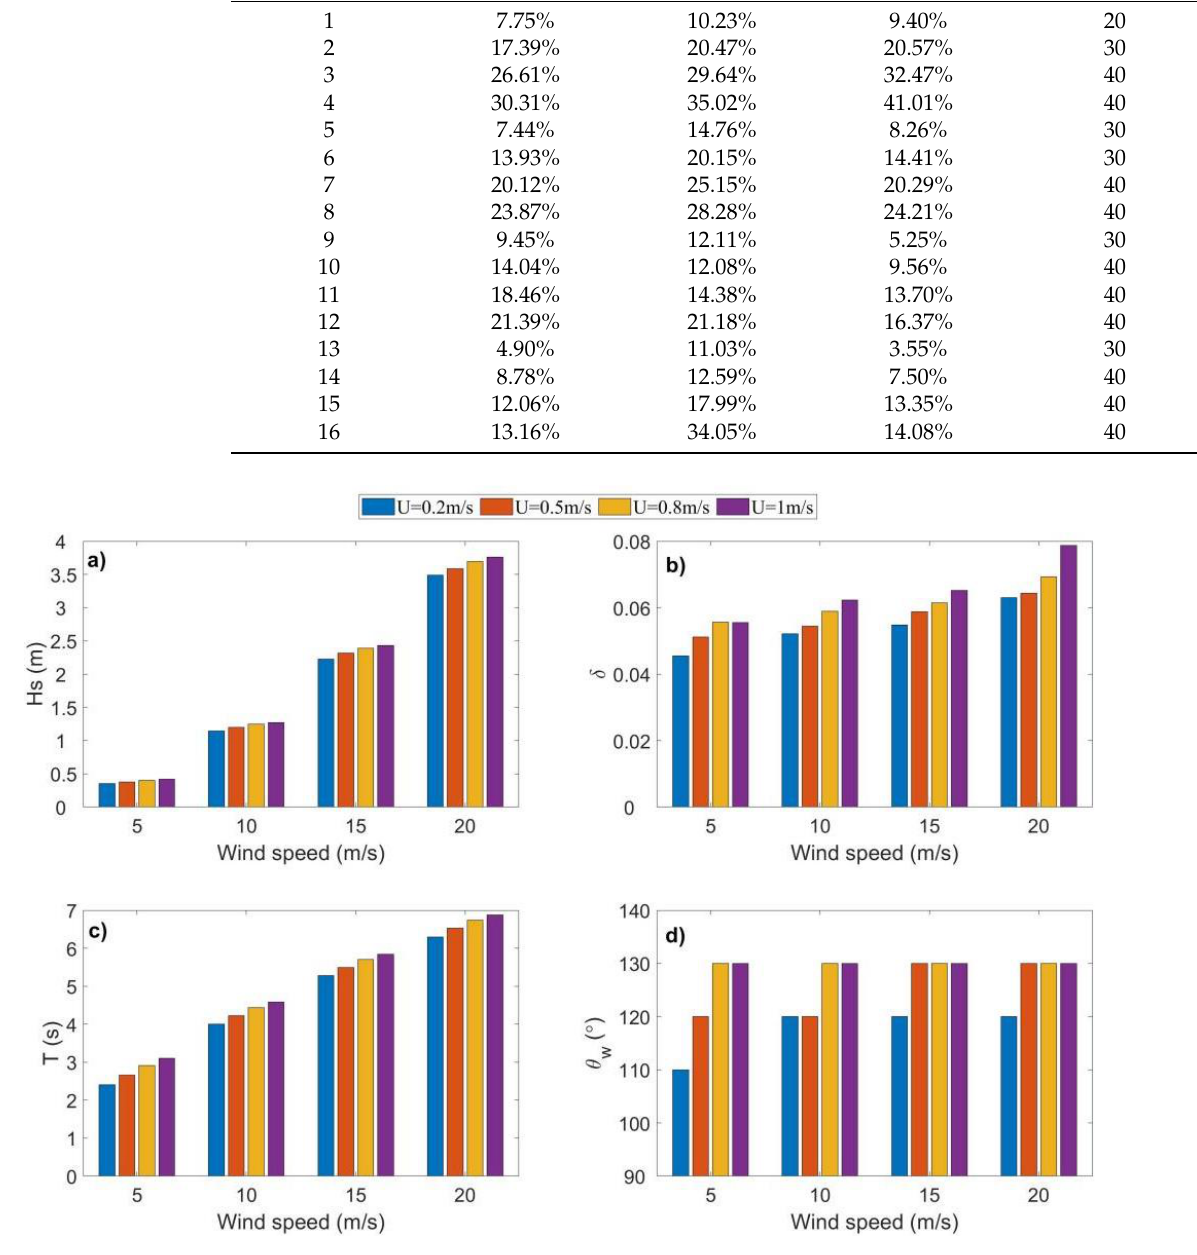
Figure 7. Wave parameters ( a ) H S , ( b ) δ , ( c ) T , and ( d ) θ w for the 16 cases in Table 1. The horizontal coordinates represent the different wind speeds (5, 10, 15, and 20 m/s). of each point under Case 16 (Figure 2; P1 – P9) are drawn in Figure 8. It can be seen that from P1 to P9, the wave height and average wave steepness reached the minimum at P3 (corresponding to the upper part of Figure 3a and Figure 5a) and the maximum at P7 (corresponding to the lower part of Figure 3a and Figure 5a), while the mean wave period changed in reverse. The peak wave direction became larger at P3 and smaller at P7, which corresponds to Figure 6a. The analysis of wave distribution from the perspective of this section can deepen the understanding of wave field variations.